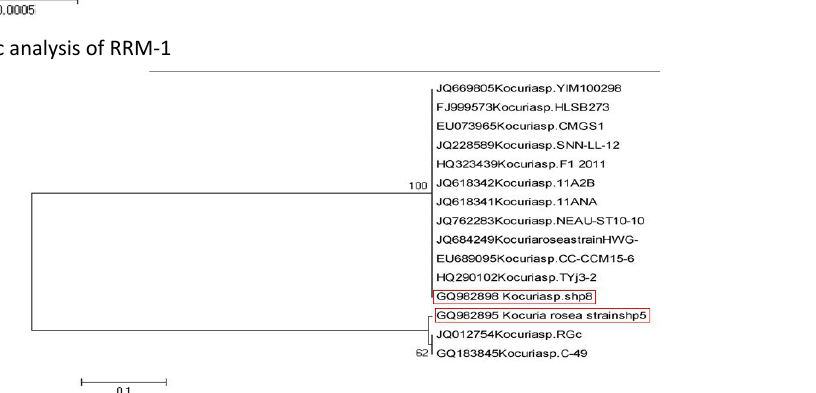
Fig. 7. Phylogenetic analysis of WSS-2 and SShFM-1